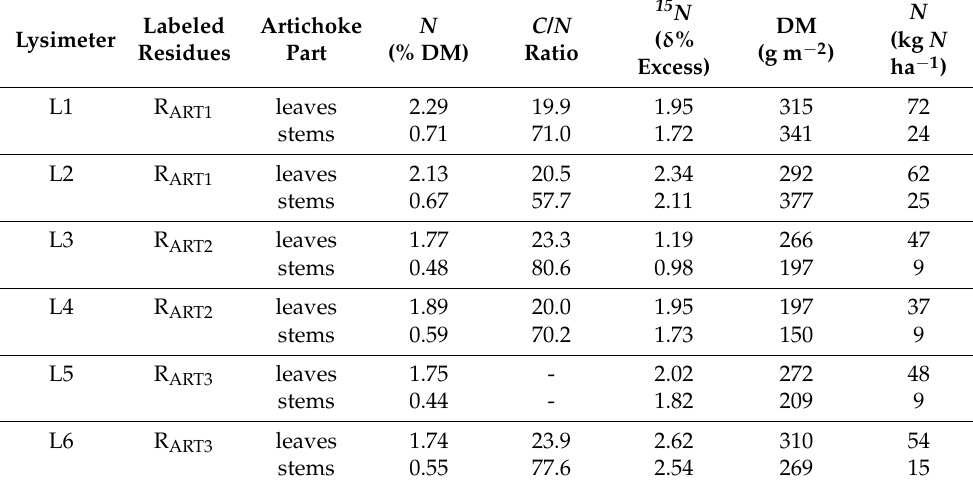
Table 1. C/N ratio, 15 N concentration and amounts of dry matter (DM) and N of 15 N -labeled artichoke leaves and stems incorporated into lysimeter